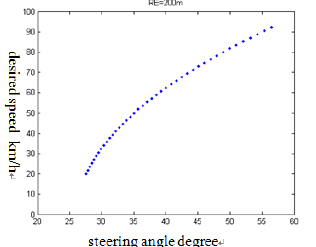
Fig.14 the relationship between steering wheel and desired speed of the study